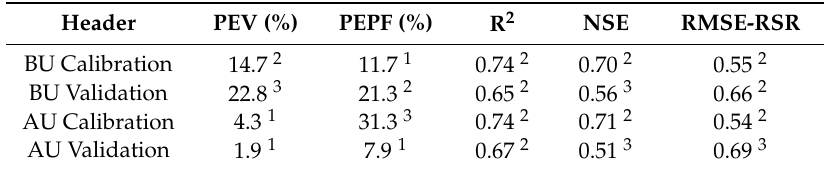
Table A3. Goodness of fit statistics for models calibrated and validated for the before urbanization (BU) period and after urbanization (AU) period. Footnotes indicate performance ratings